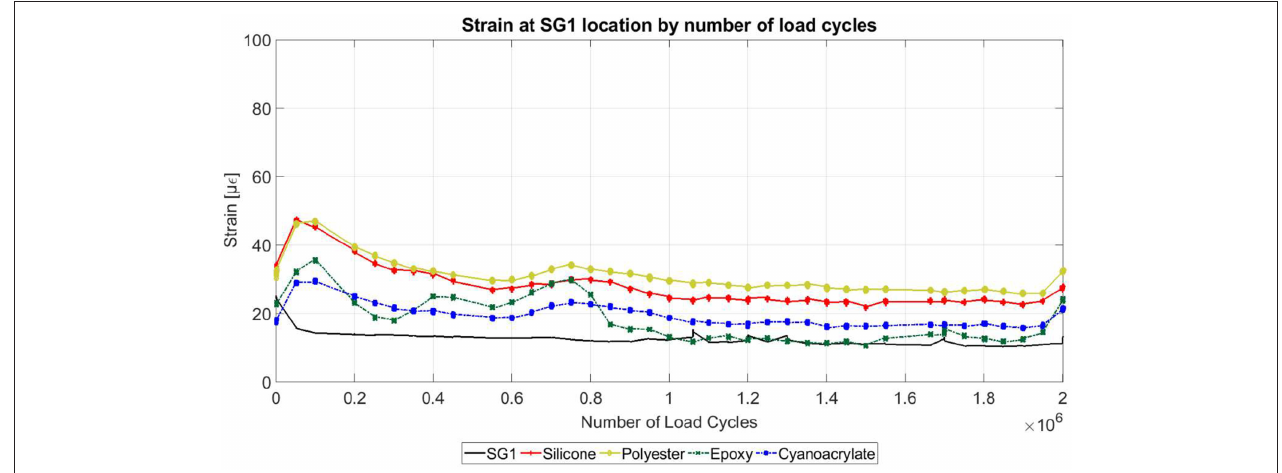
FIGURE 14 | Measured strain at beam FA2 at SG1 location over the load cycles.